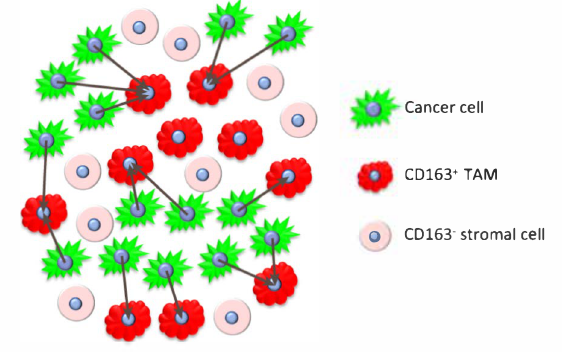
Figure 1. Computation of the nearest neighbor distances (NND) from each cancer cell to the nearest CD163 +